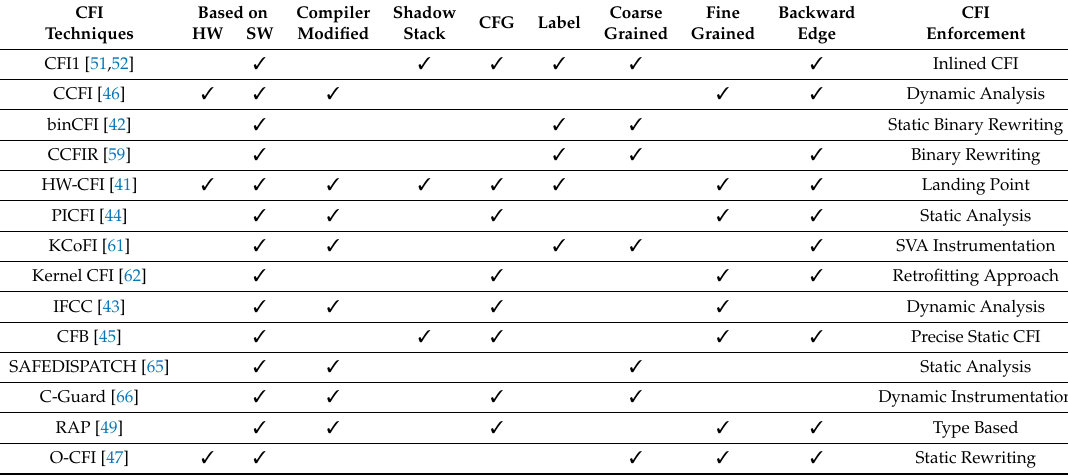
Table 1. Key features of CFI